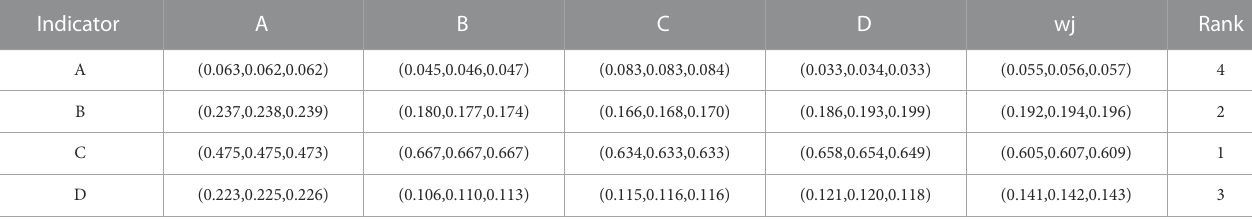
TABLE 9 Standard weight and ranking of criteria layer (MCS-AHP).